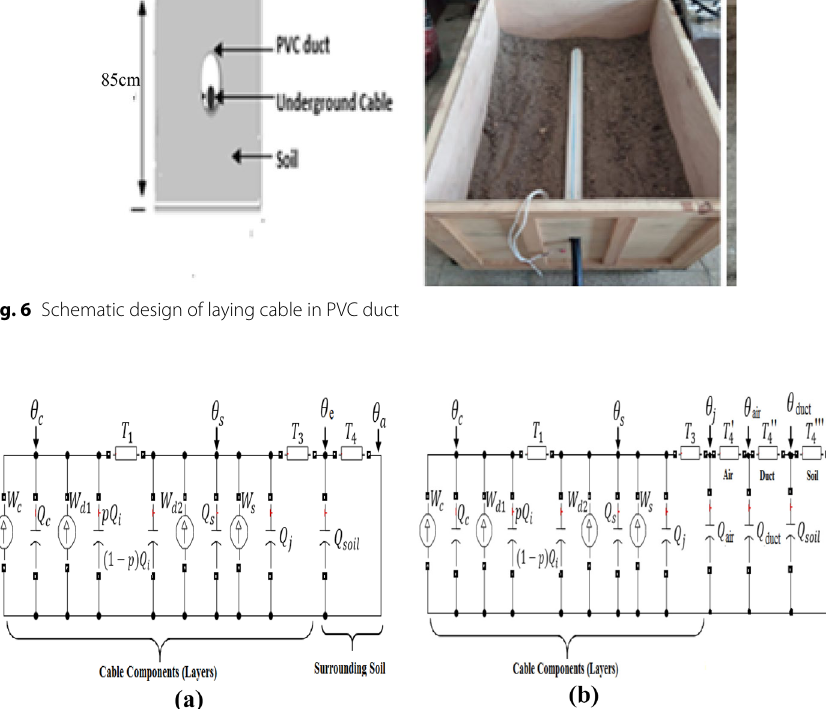
Fig. 7 Thermal equivalent circuit for single core cable parts and the around soil, a for direct buried, b for cable install in duct and buried in the